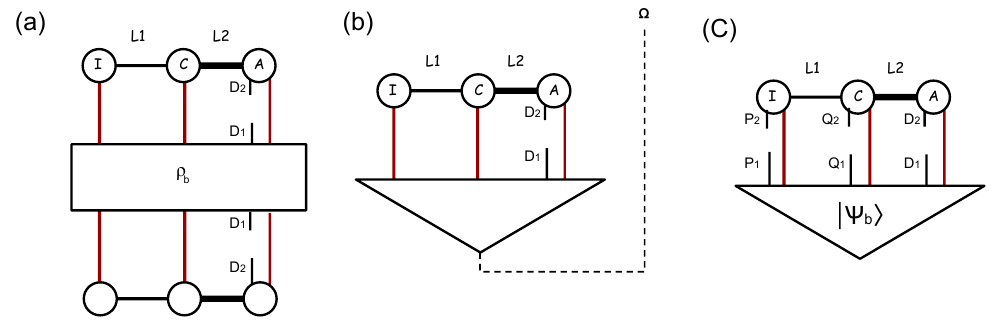
Figure 19. (a) A small probe D in a closed universe without boundary. The super-density operator (cid:27) D consists of ancilla system D 1 ; D 2 . (b) A pure state of D 1 ; D 2 ; (cid:10) de(cid:12)ned by puri(cid:12)cation of (cid:26) b . (c) A pure state closed universe with small probes P; Q and a large probe in region A